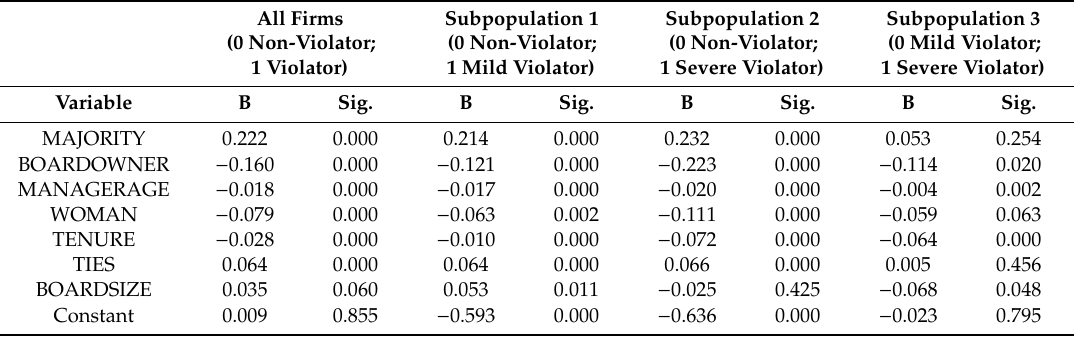
Table 4. Additional logistic regression models for the subpopulations of BINARYDELAY in comparison with the base model.